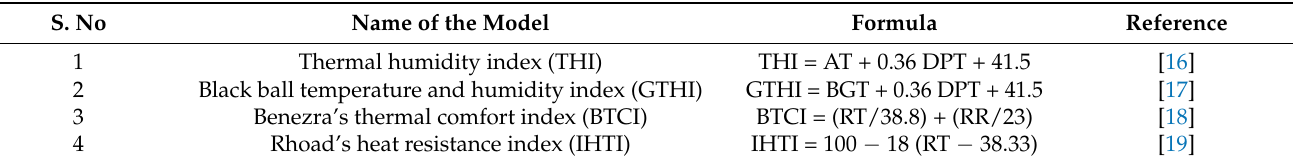
Table 2. Previously reported thermal comfort models used for comparison with new